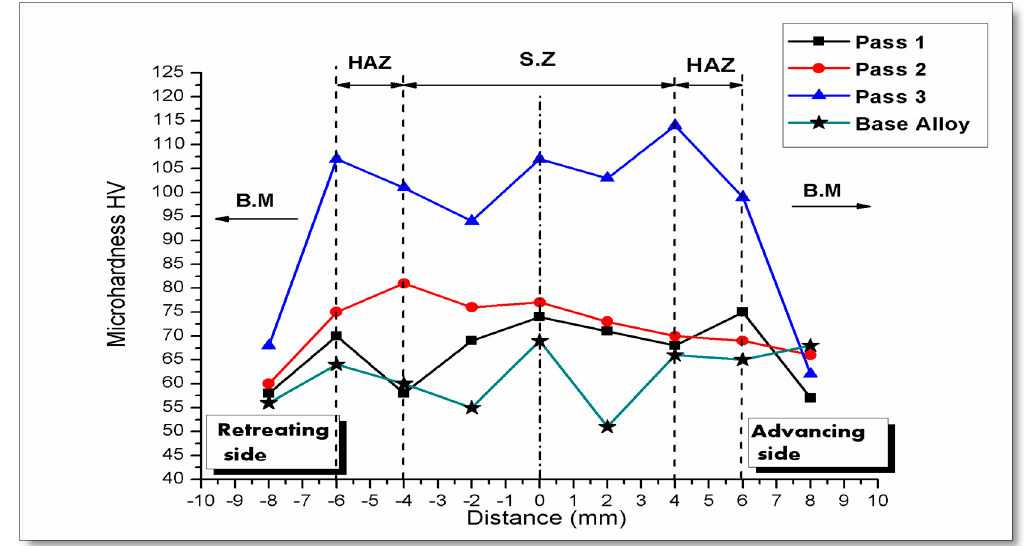
Figure 18. Microhardness profile through a cross section in friction stir processing at 900 rpm with a 10 mm/min traverse speed.